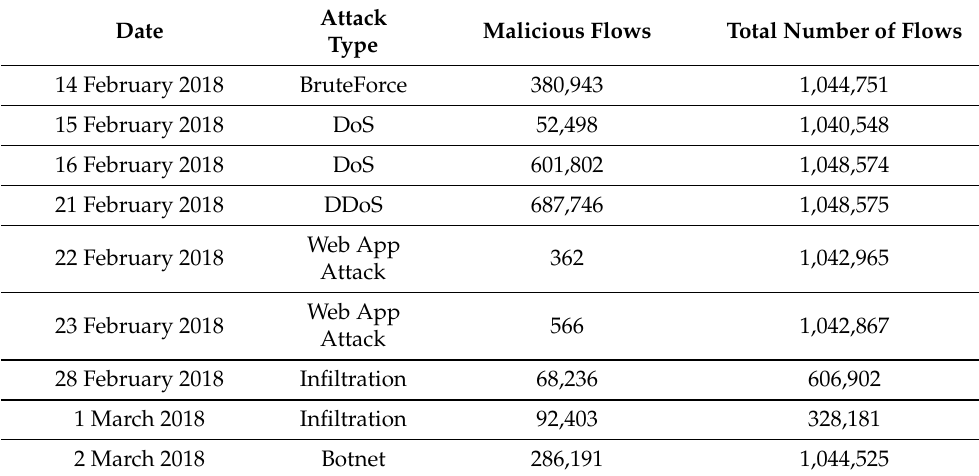
Table 1. Detailed of the attacks used for benchmark.